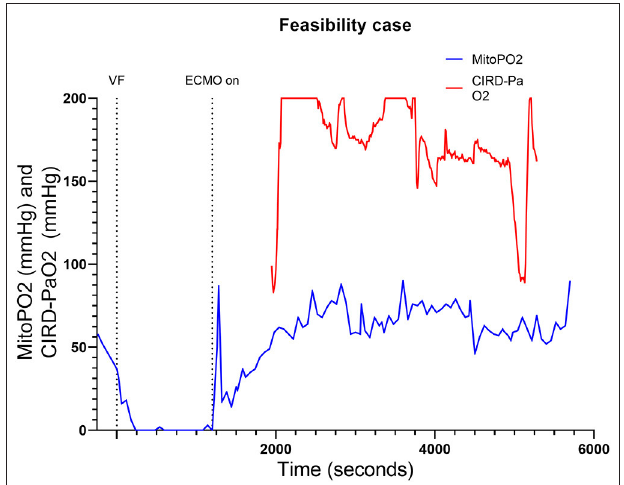
FIGURE 1 | Course of mitoPO 2 and CIRD-PaO 2 for the feasibility test. Course of mitoPO 2 and CIRD-PaO 2 in mmHg levels over time in seconds. VF, ventricular fibrillation; ECPR, extracorporeal cardiopulmonary resuscitation; CIRD-PaO 2 , arterial partial oxygen pressure measured by controlled integrated resuscitation device; mitoPO 2 , mitochondrial partial oxygen